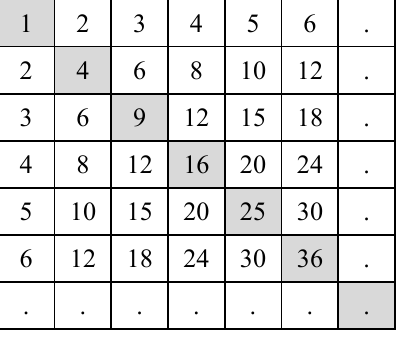
Figure 7 : The square numbers in Figure